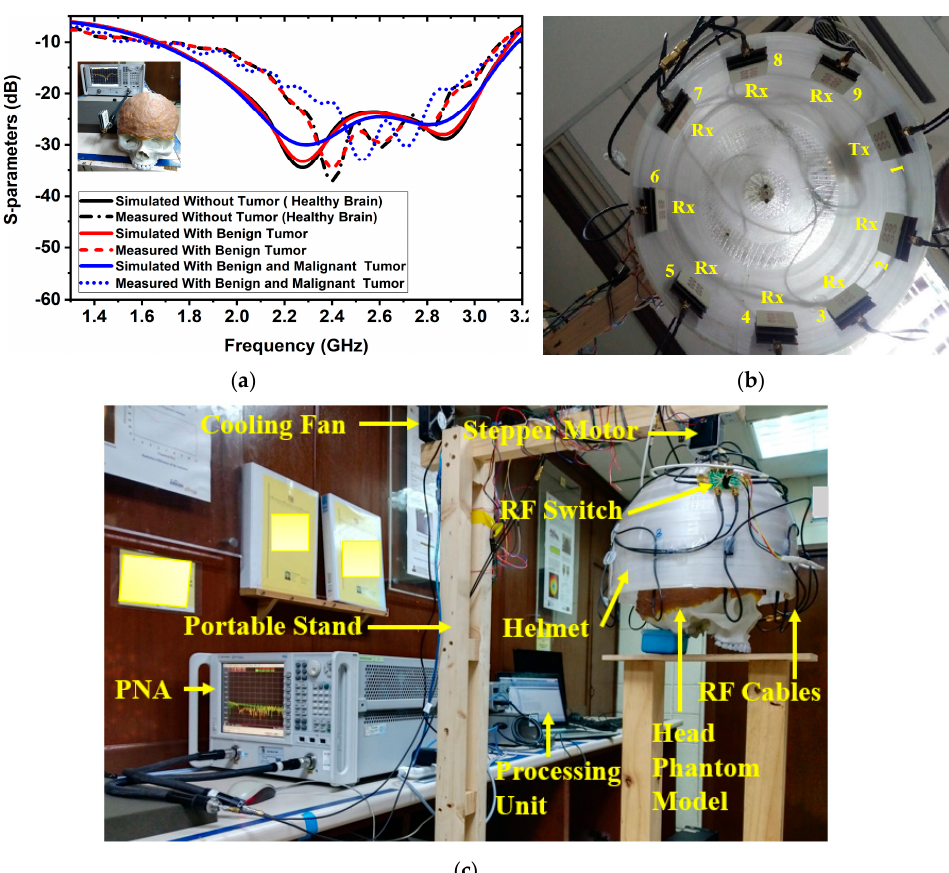
Figure 2. Antenna sensor measurements and experimental setup for the SMBI system: ( a ) Measured and simulated results of the antenna sesnor with a fabricated head phantom model, ( b ) MTM loaded 3D stacked antenna sensor inside the helmet, ( c ) Overall SMBI system